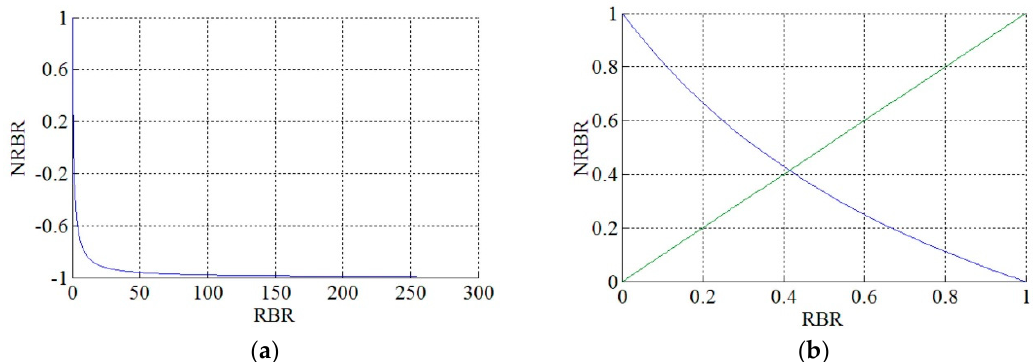
Figure 10. Relationships between NRBR and RBR: ( a ) Theoretical relationship; ( b ) actual relationship.